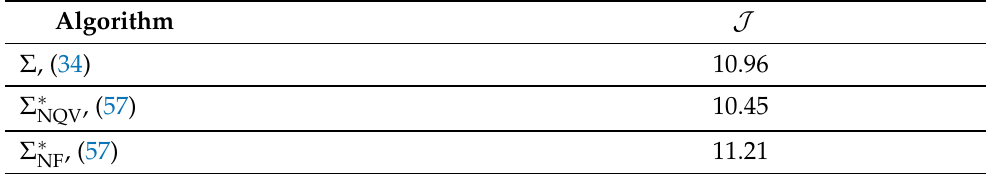
Figure 4. Area of convergence: ( a ) Σ , ( b ) Σ ∗ Table 5. Comparison of values of performance index obtained for the same initial